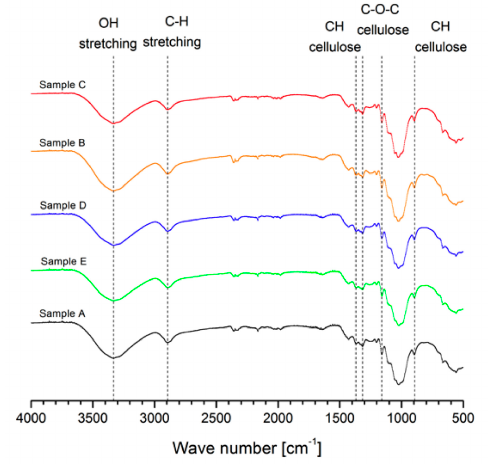
Figure 3. FTIR spectra for the five CNC samples selected.